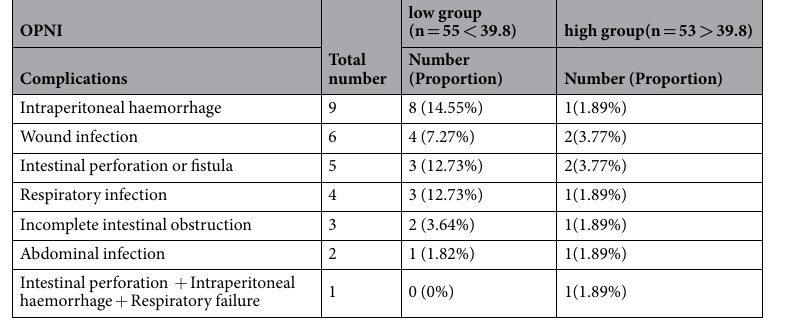
Table 4. The incidence of seven complications in the low and high OPNI